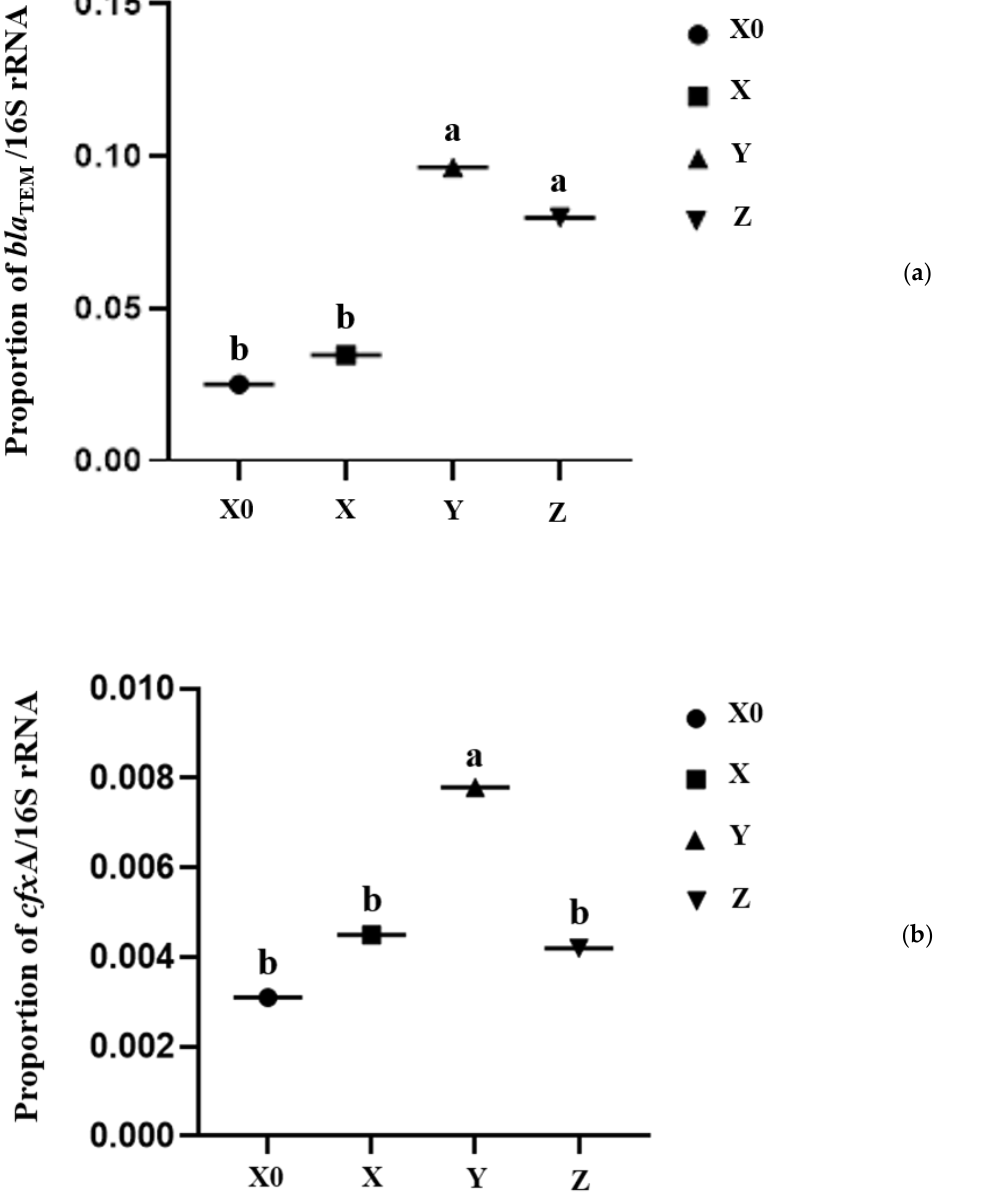
Figure 4. Proportion of the antibiotic resistance genes ( a ) bla TEM and ( b ) cfx A compared with the 16S rRNA gene. Different lowercase letters suggest significantly different means ( p < 0.05). X0, X, Y, and Z indicate the periods Day 0, medication, withdrawal, and recovery, respectively.